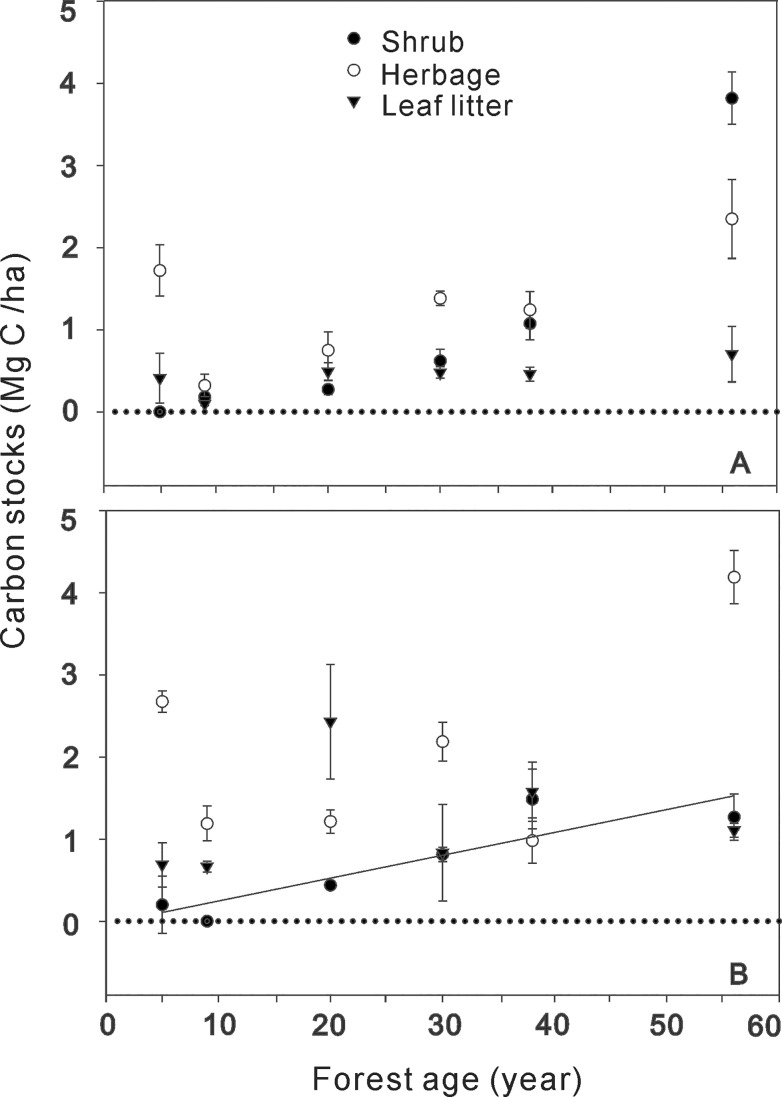
Secondary biomass C (SBC) of black locust plantations in drier (A) and wetter zone (B) across the chronosequence.Shrub C stock against forest age in wetter zone (B) performed significant linear regression relationship as follow: y = −0.033 + 0.028 x (R2 = 0.80, P = 0.01). The values of C stock lie on the level of zero represent that these components was not found in the plantations; the bars represent the standard deviation.